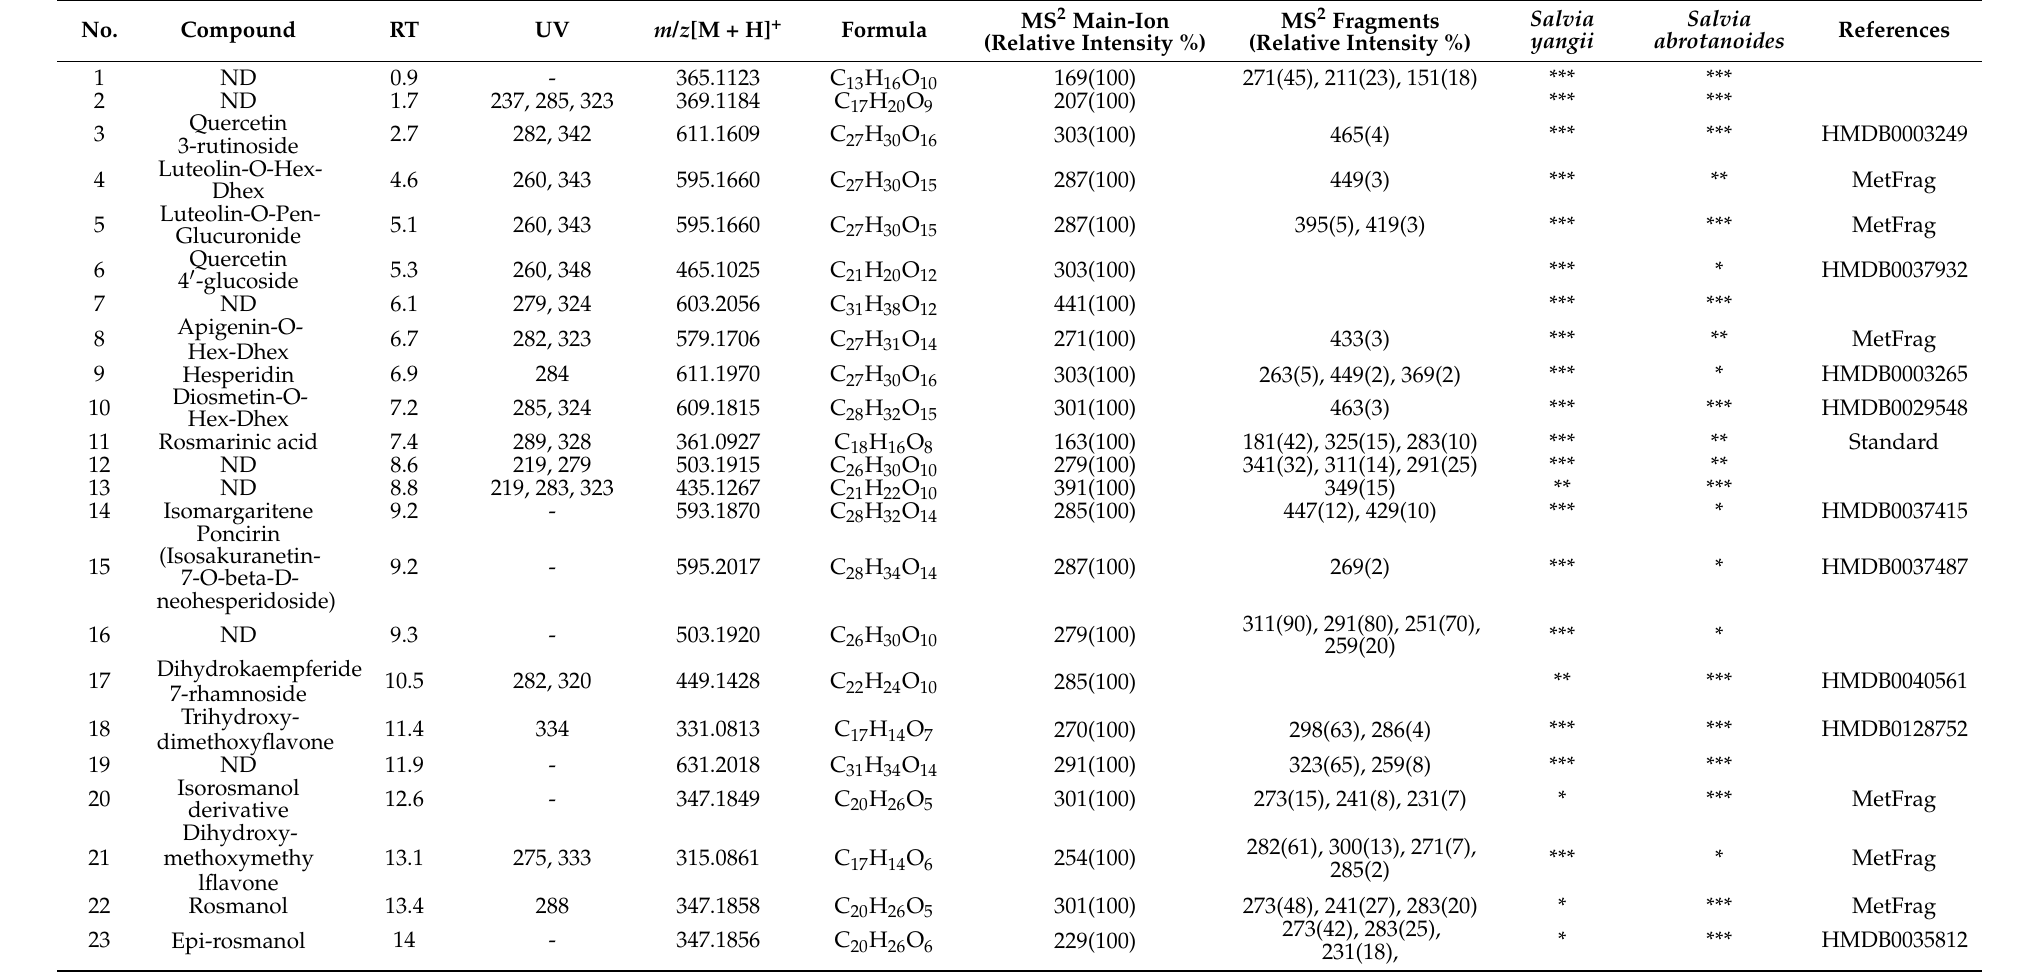
Table 2. Characterization of identified compounds in leaves of S. yangii and S. abrotanoides , UHPLC–QTOF-MS in positive ion